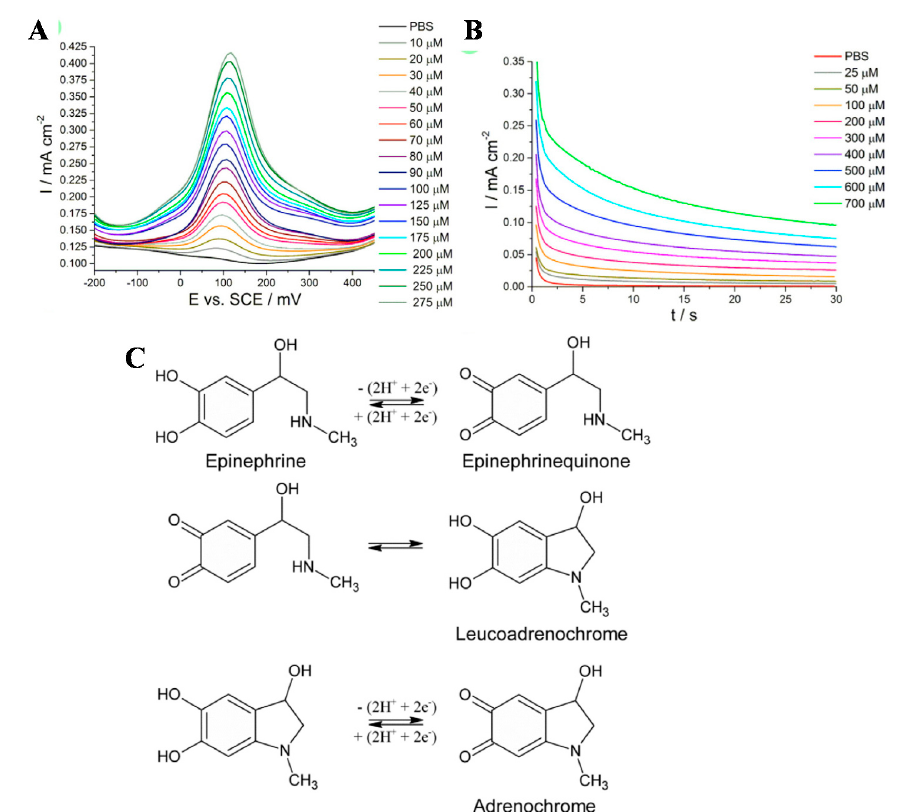
Figure 2. ( A ) Differential pulse voltammetry; ( B ) amperometry response of the nanoporous sponge- like Au – Ag electrode in 0.1 M PBS containing different concentrations of epinephrine (EP); ( C ) The